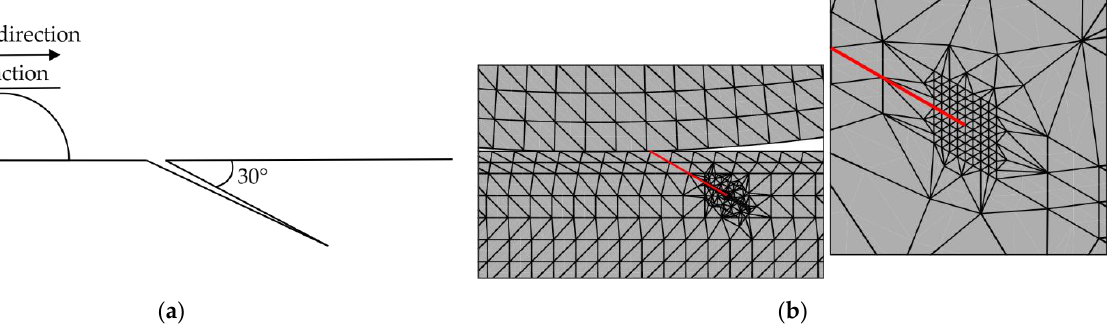
Figure 16. Rolling procedure and FE model to simulate rolling contact fatigue ( a ). Rolling procedure with rolling direction, traction, and crack at an angle of 30°; ( b ) Detail from the FE model along with the crack.